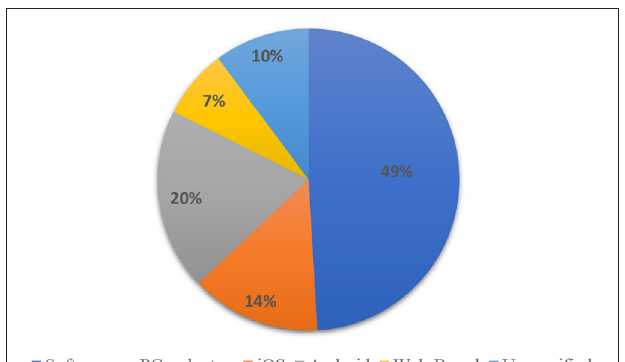
FIGURE 6 | The game platform used by the reviewed